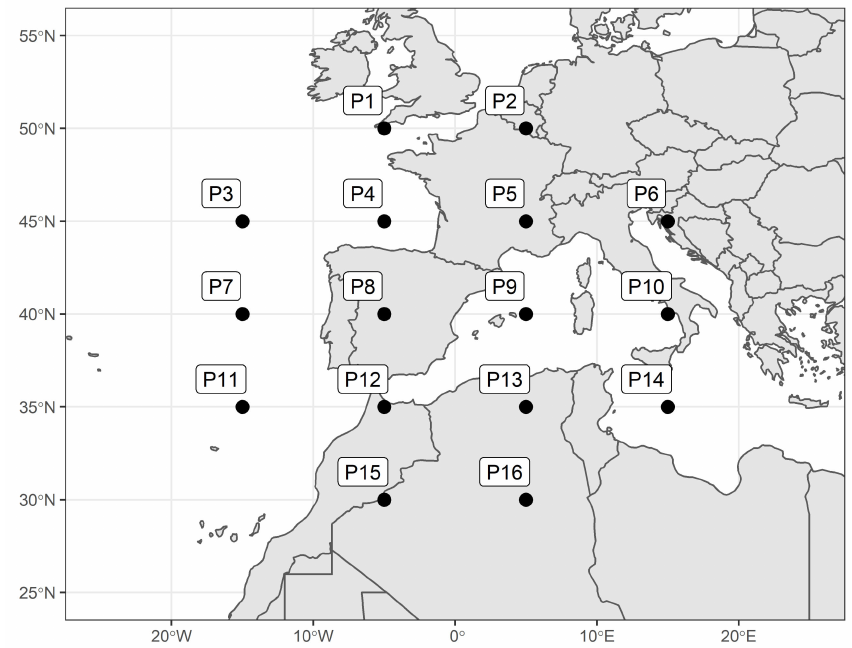
Figure 3. The 16-point grid used in the J&C